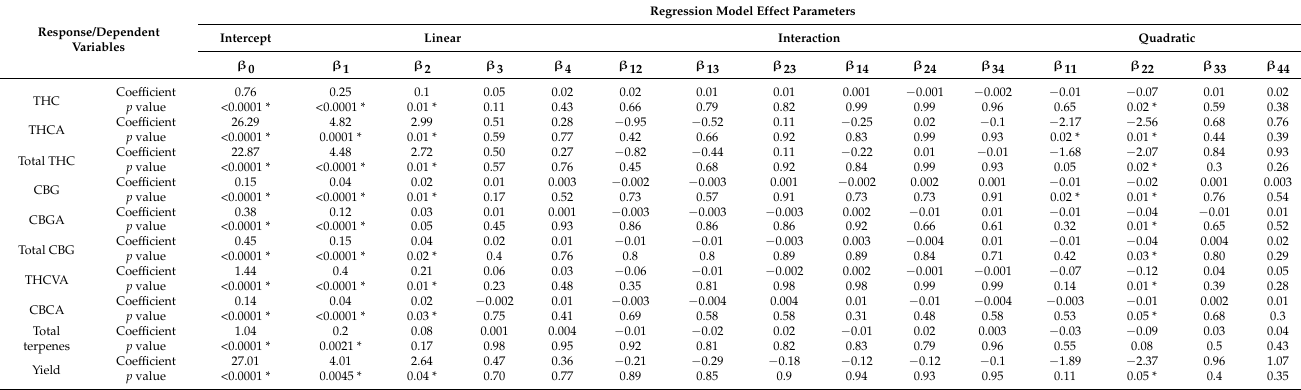
Table 4. Matrix of the central composite rotatable statistical design (CCRD) and observed responses (Y j ) for ultrasound-assisted extraction using model A (Y j = β 0 + β 1 X 1 + β 2 X 2 + β 3 X 3 + β 4 X 4 + β 11 X 1 X 1